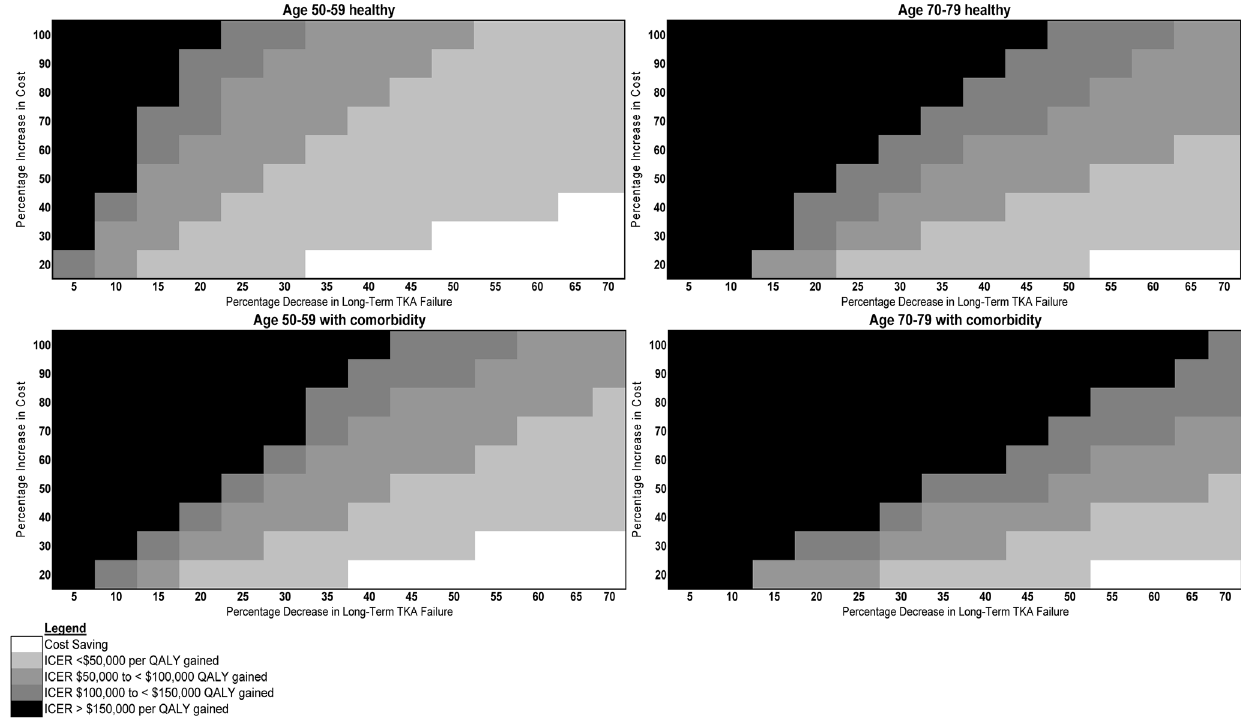
Figure 2. Implant cost and long-term TKA failure rate thresholds. Each shaded area represents implant cost increases (vertical axis) and failure rate reductions (horizontal axis) required to achieve a given ICER range (see Legend contained in Figure) among the four primary cohorts. ICER=incremental cost-effectiveness ratio in 2010 US $ per quality-adjusted life-year (QALY) gained, compared with standard TKA.